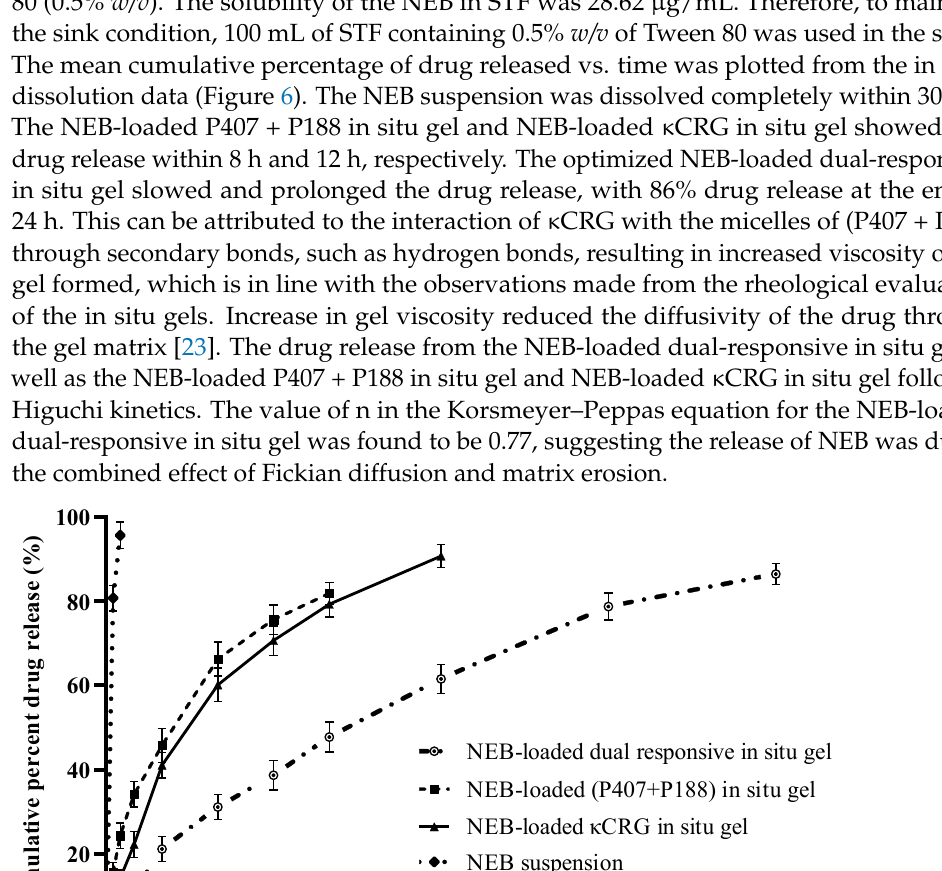
Figure 7. Images obtained from the HET ‐ CAM test following the exposure of the CAM membrane to ( A ) negative control (0.9% w/v NaCl); ( B ) positive control (0.1 N NaOH); ( C ) blank dual ‐ respon ‐ sive in situ gel and ( D ) NEB ‐ loaded dual ‐ responsive in situ gel.